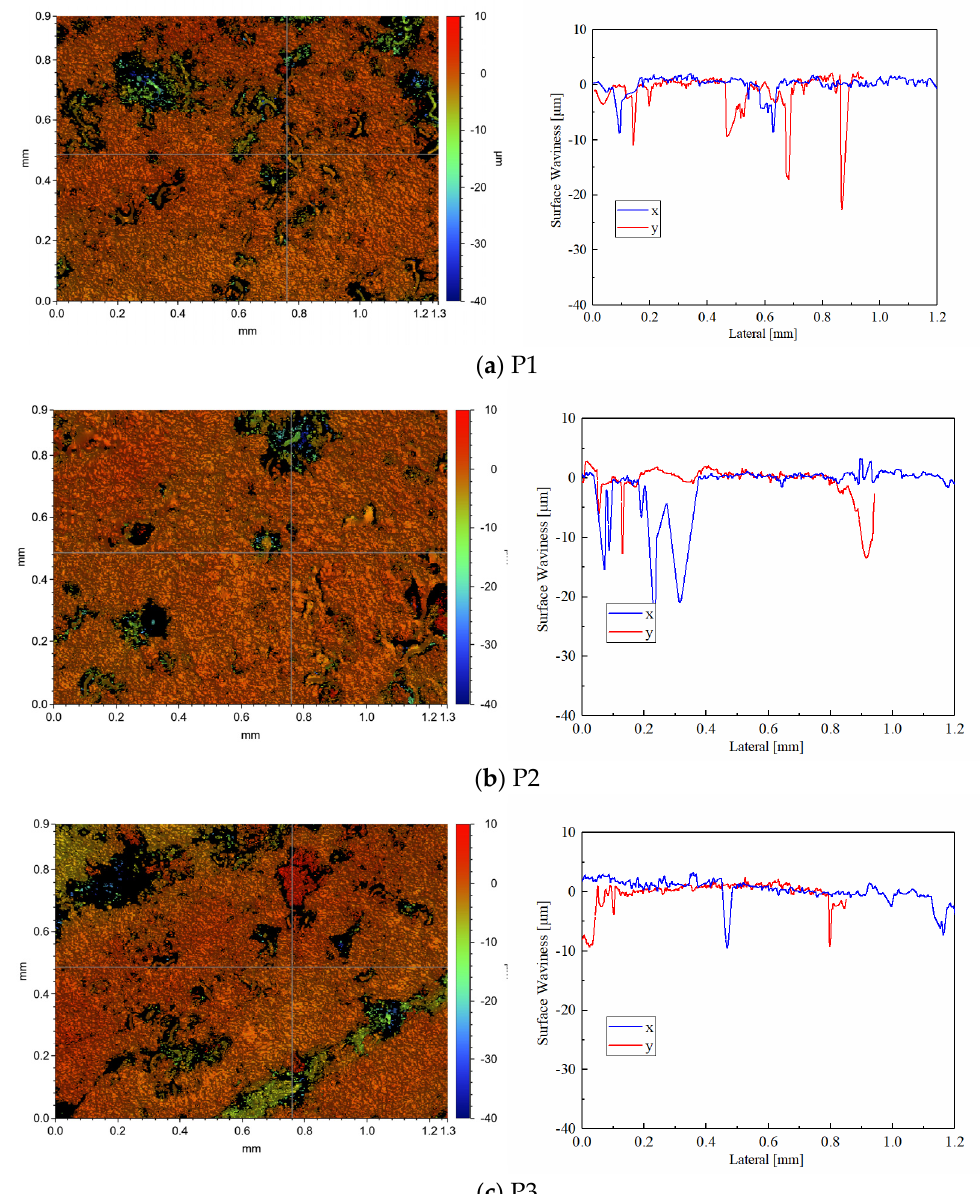
Figure 12. The post-test white light interferometric profilometry ( a – c ) (×50) of the test sample CBFM-A.